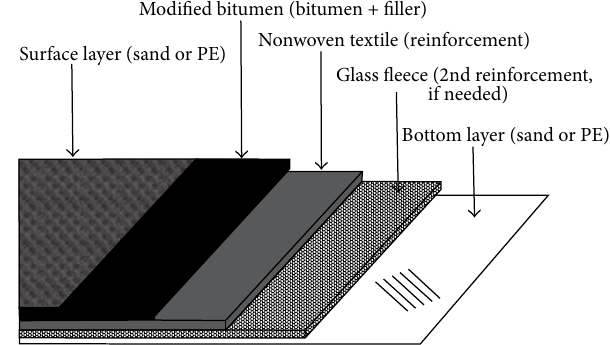
Figure 1: Bituminous geomembrane